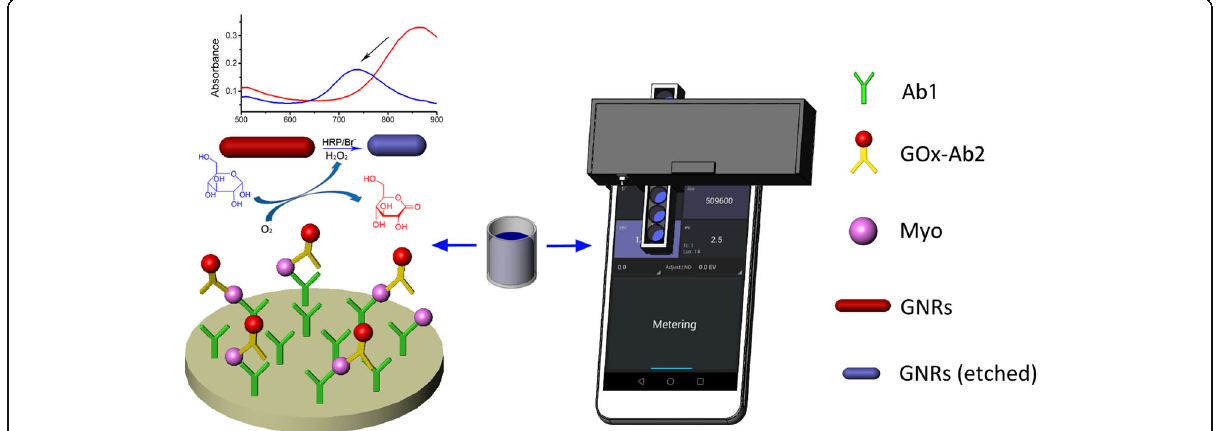
Fig. 1 Schematic diagram of the AuNRs-based plasmonic immunoassay for Myo